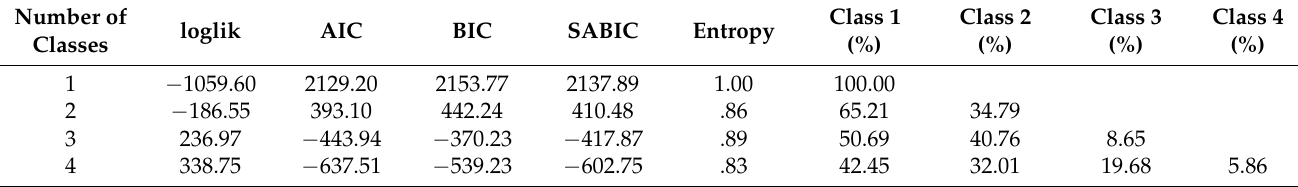
Table 2. Latent Class Growth model for EFD longitudinal pattern in